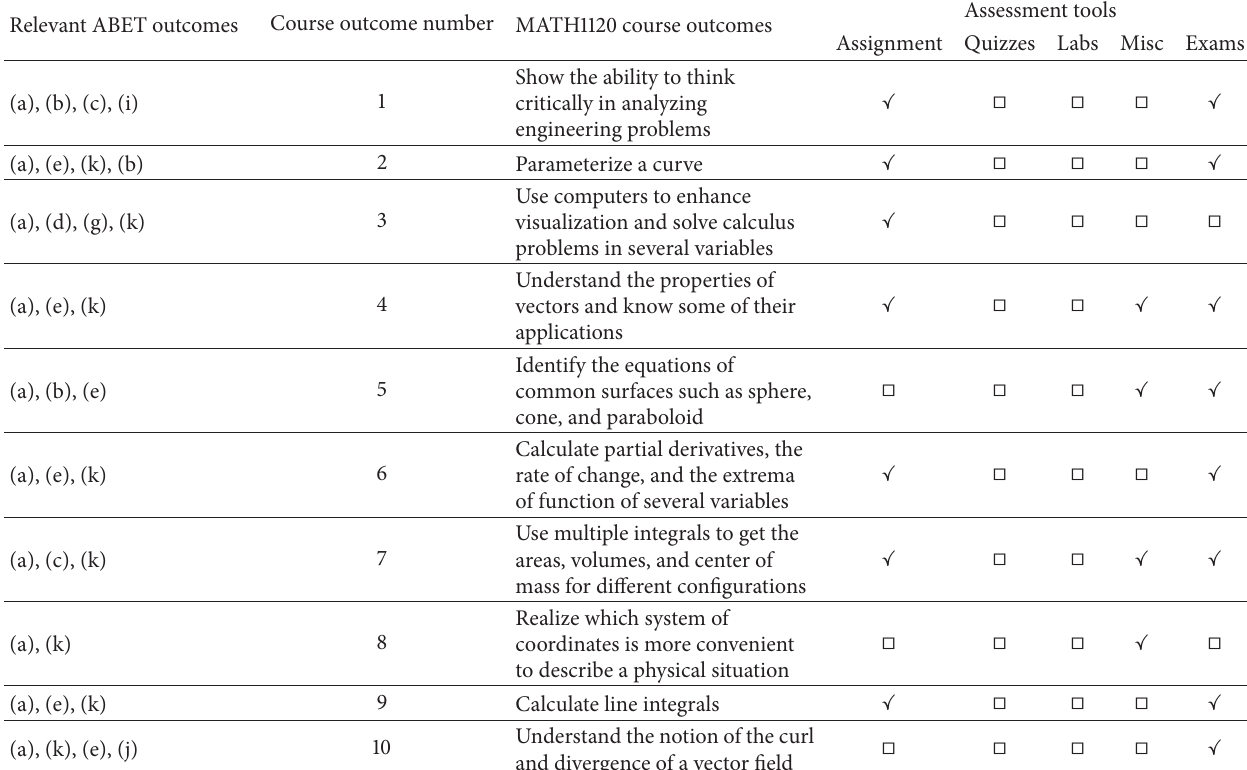
Table 2: Course outcomes, mapping with ABET and students direct assessment tools for the course MATH1120-Calculus II for engineers. Relevant ABET outcomes